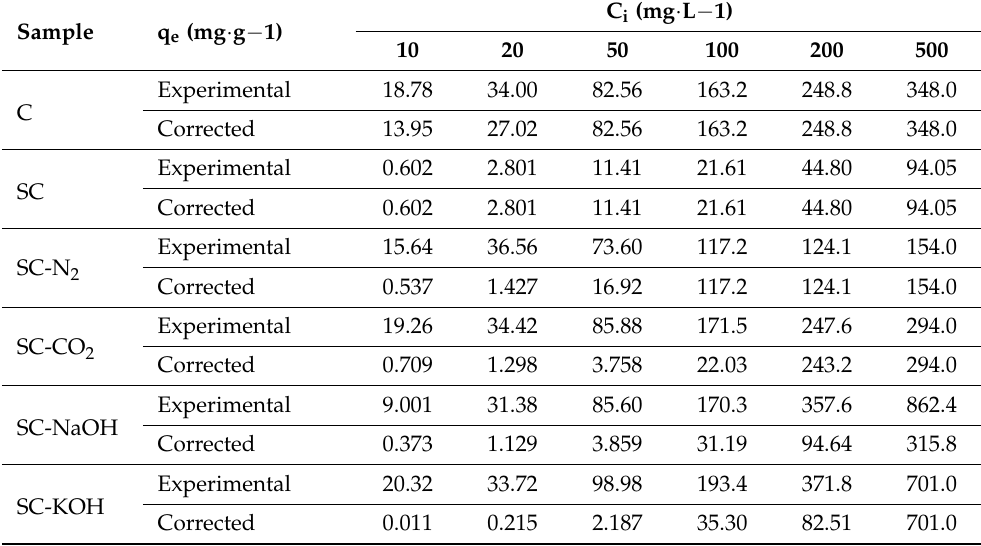
Figure 8. Evolution of the adsorption equilibria pH with the initial concentration of Pb. Table 3. Experimental adsorption capacities and corrected adsorption capacities after